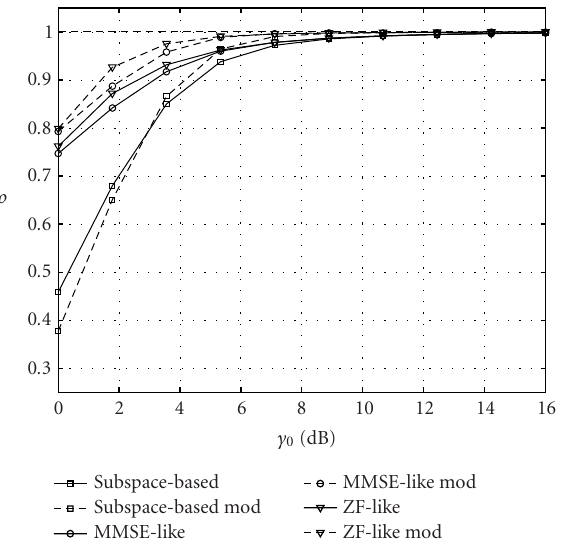
Figure 8: Channel estimation for a cooperative reception scheme: K = 4, M = 8, n t = 2, n r = 2, Q = 1300, and P = 1500. is reported versus γ 0 . Here, the word “mod” in the legends